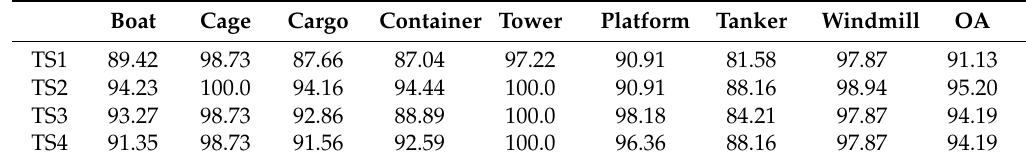
Table 9. Classification accuracies (%) of MT-CNN trained with different augmentation